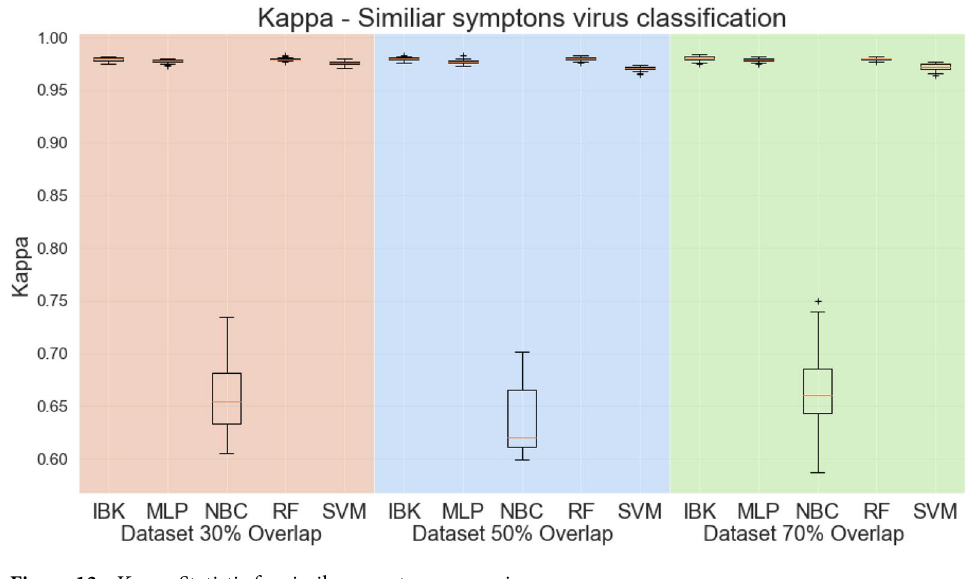
Figure 13. Kappa Statistic for similar symptoms